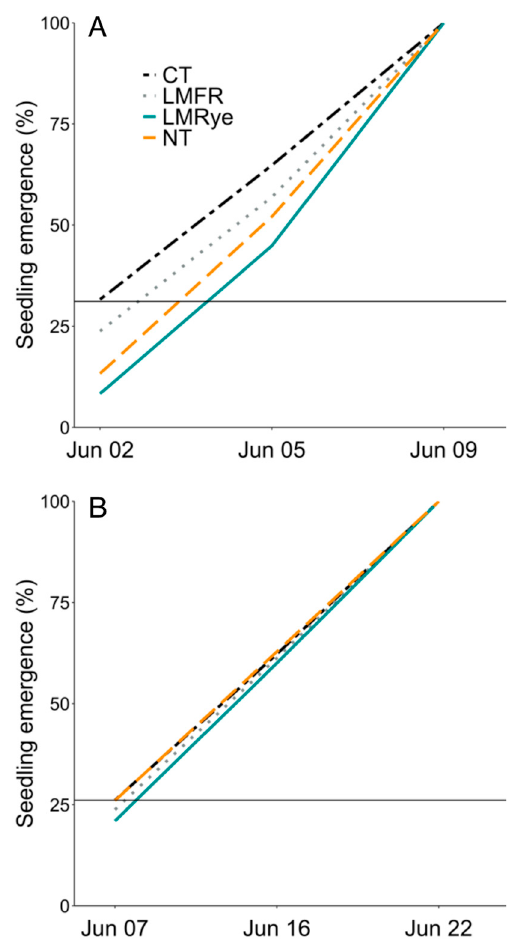
Figure 3. Percent of total sweet corn seedling emergence by sample date in ( A ) 2020 and ( B ) 2021 in conventional till (CT), no-till (NT), living mulch + forage radish residue (LMFR), and living mulch + rye residue (LMRye). Horizontal line marks the initial stand count in CT. Table 3. Mean ± SEM plant development and yield metrics for 2020 and 2021.